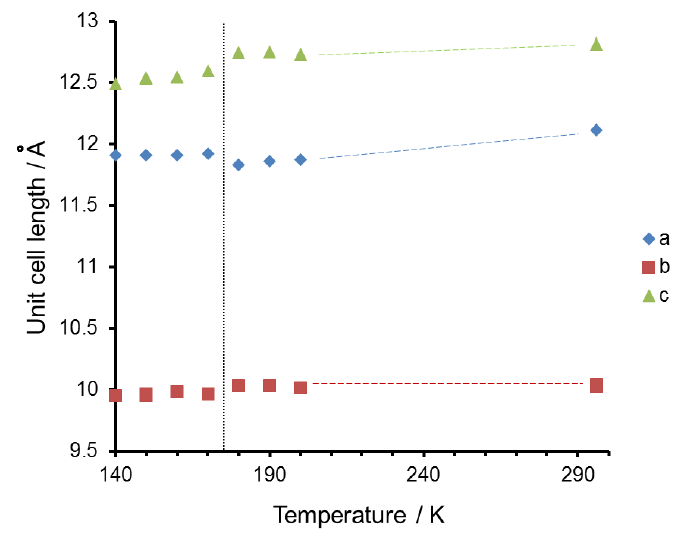
Figure 1. A plot of the unit cell parameters as a function of temperature. The dotted vertical line indicates the phase transition point.